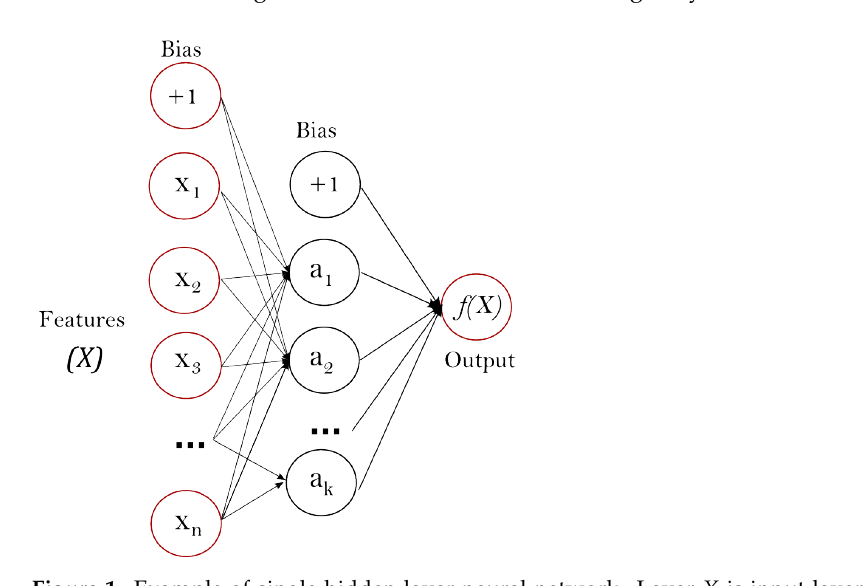
Figure 1. Example of single hidden layer neural network. Layer X is input layer, layer a is hid- den layer. The image is taken from https://scikit-learn.org/stable/modules/neural_networks_